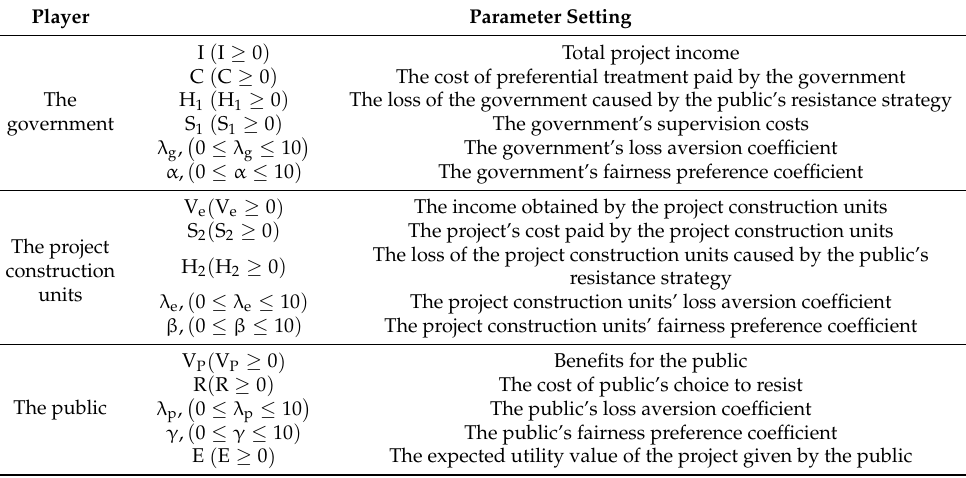
Table 1. Model parameter settings of each player in the